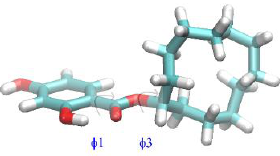
Figure 1. The structure of the lowest DFT energy conformer (K1) and definitions of the scanned torsional angles ( ϕ 1 = C2-C1-C7-O4, ϕ 3 = C7-O4-C8-C9).